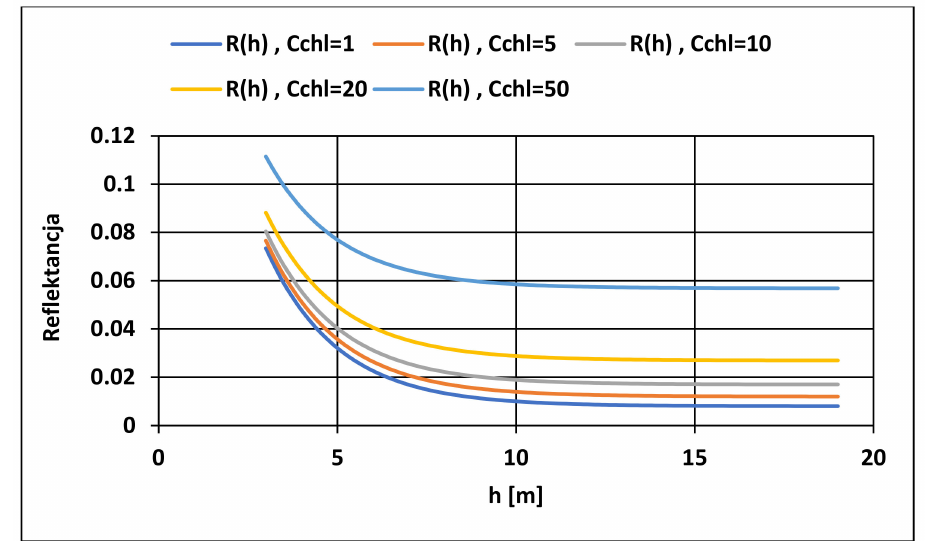
Figure 12. Changes in reflectance R as a function of depth h for the sensor above the water surface at different concentrations of chlorophyll a C chl = {1, 5, 10, 20, 50} mg/m 3 .